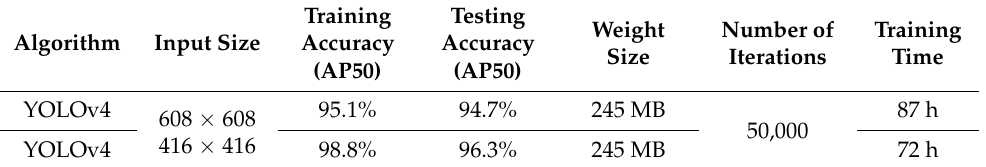
Table 5. Constructing pretrained weights using